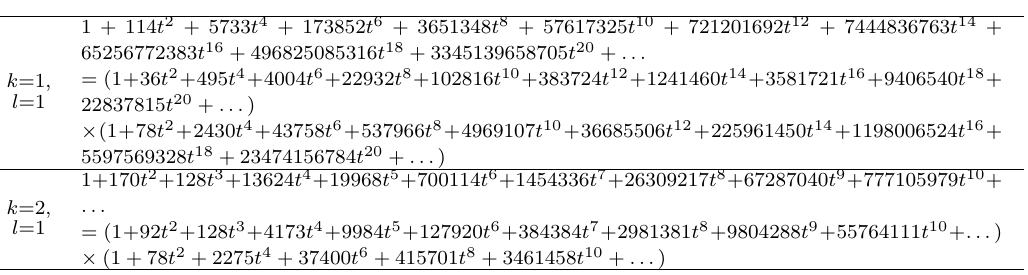
Table 17. Hilbert series results for (3.10). The first line displays the Coulomb branch Hilbert series for (3.10), while the second line displays the factorisation into a product. Each factor agrees with the known Hilbert series.